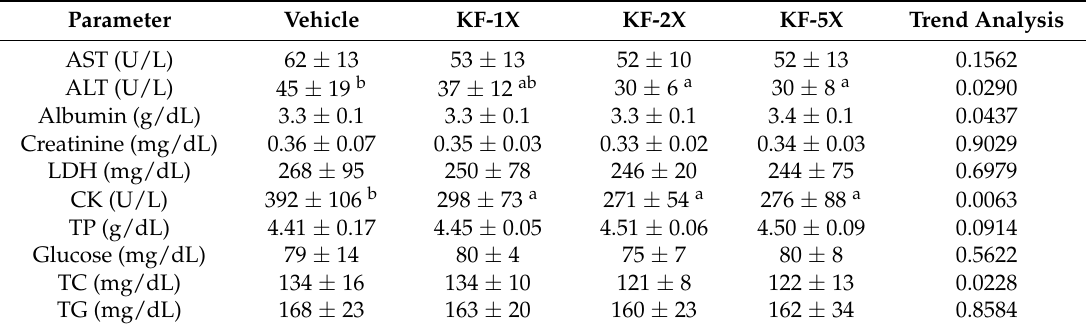
Table 2. Biochemical analysis with kefir (KF) supplementation at the end of the experiment. Parameter Vehicle KF-1X KF-2X KF-5X Trend Analysis AST (U/L) 62 ± 13 53 ± 13 52 ± 10 52 ± 13 0.1562 ALT (U/L) 45 ± 19 b 37 ± 12 ab 30 ± 6 a 30 ± 8 a 0.0290 Albumin (g/dL) 3.3 ± 0.1 3.3 ± 0.1 3.3 ± 0.1 Creatinine (mg/dL) 0.36 ±